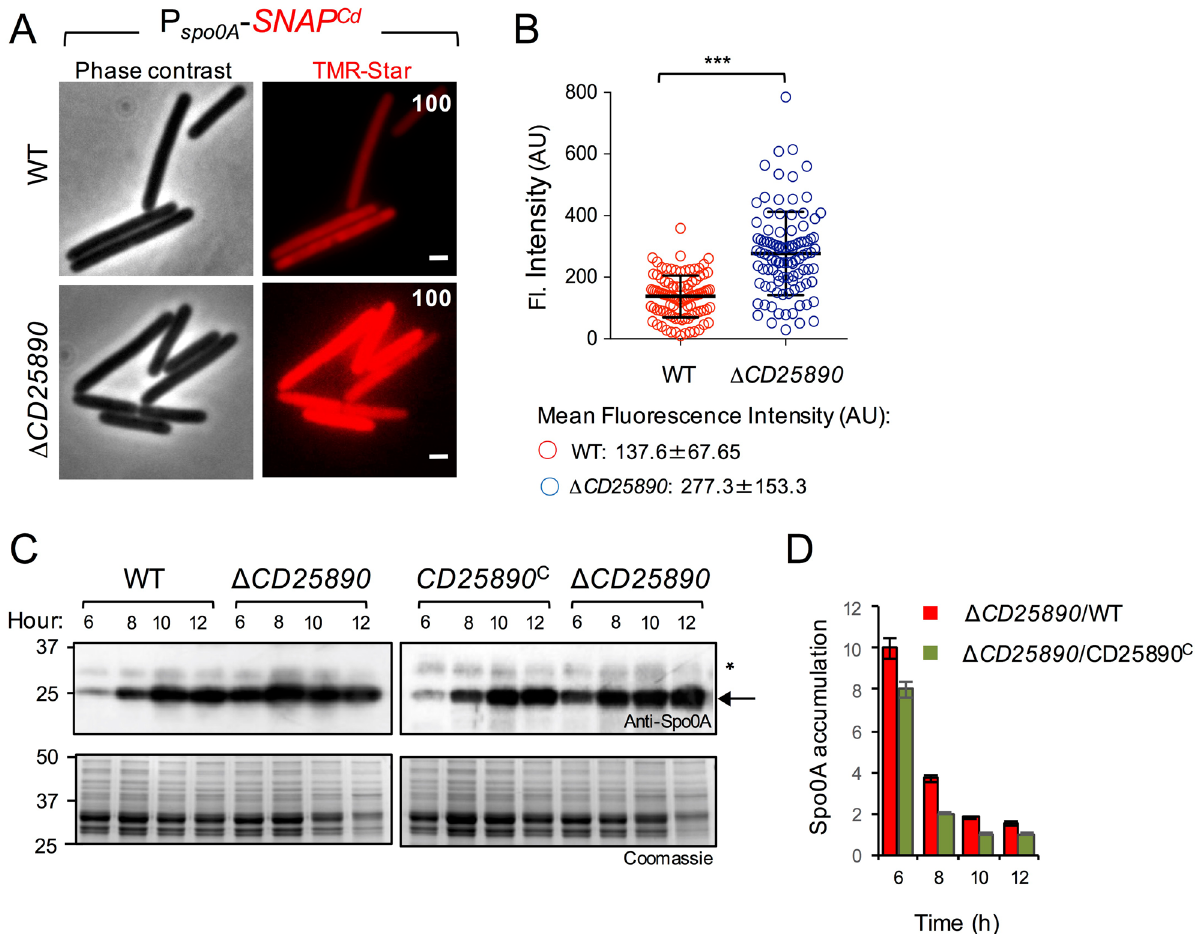
Figure 4. Increased expression of spo0A in the (cid:31) CD25890 mutant. A: Microscopy analysis of C. difficile cells carrying a P spoOA - SNAP Cd transcriptional fusion in the WT and congenic (cid:31) CD25890 mutant. The cells were collected after 10 h of growth in SM broth, stained with TMR-Star, and examined by fluorescence microscopy to monitor SNAP production. The panels are representative of the expression patterns observed. The numbers refer to the percentage of cells showing SNAP fluorescence. Data shown are from one experiment and are representative of at least three independent experiments. Scale bar, 1 µm. B: Quantitative analysis of the fluorescence intensity (Fl.) for single cells with no signs of sporulation (n = 100 cells) of the two strains in A. Data shown are from one experiment, representative of at least three independent experiments. The numbers in the legend represent the mean and the SD of fluorescence intensity. ***, p < 0.001. Images were acquired by Metamorph™ (version 5.8; Molecular Devices) C: Samples were collected from the wild type strain (WT), the (cid:31) CD25890 mutant and the complementation strain ( CD25890 C ) grown in liquid SM, at the indicated times after inoculation. Extracts were prepared and proteins (15 µg) resolved by SDS-PAGE and subjected to immunobloting using an anti-Spo0A antibody. The position of molecular weight markers (in kDa) is indicated on the left side of the panels, and the arrow on the right indicates the position of Spo0A. D: Spo0A accumulation was assessed by quantification of the intensity of bands in the immunoblots using the Image J software and is shown as the ratio between the (cid:31) CD25890 mutant and the WT (red bars) or the complementation strain (green bars) at the indicated times (in hours) after inoculation in liquid SM. All data represent the mean ± SD from three independent